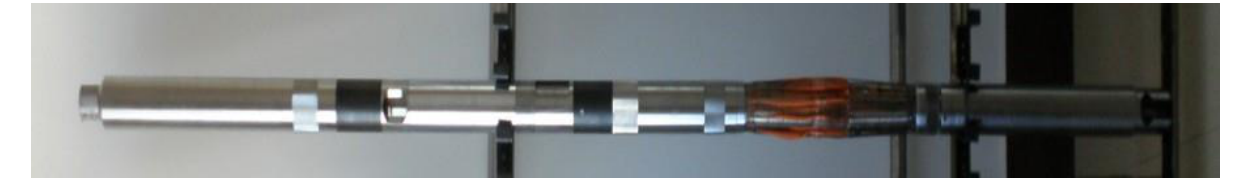
Figure 11. Experimental prototype of DGLS.